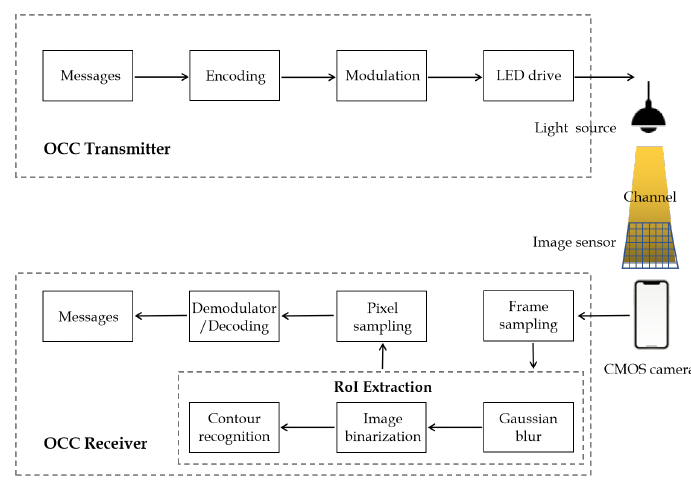
Figure 3. The schematic block diagram of an OCC